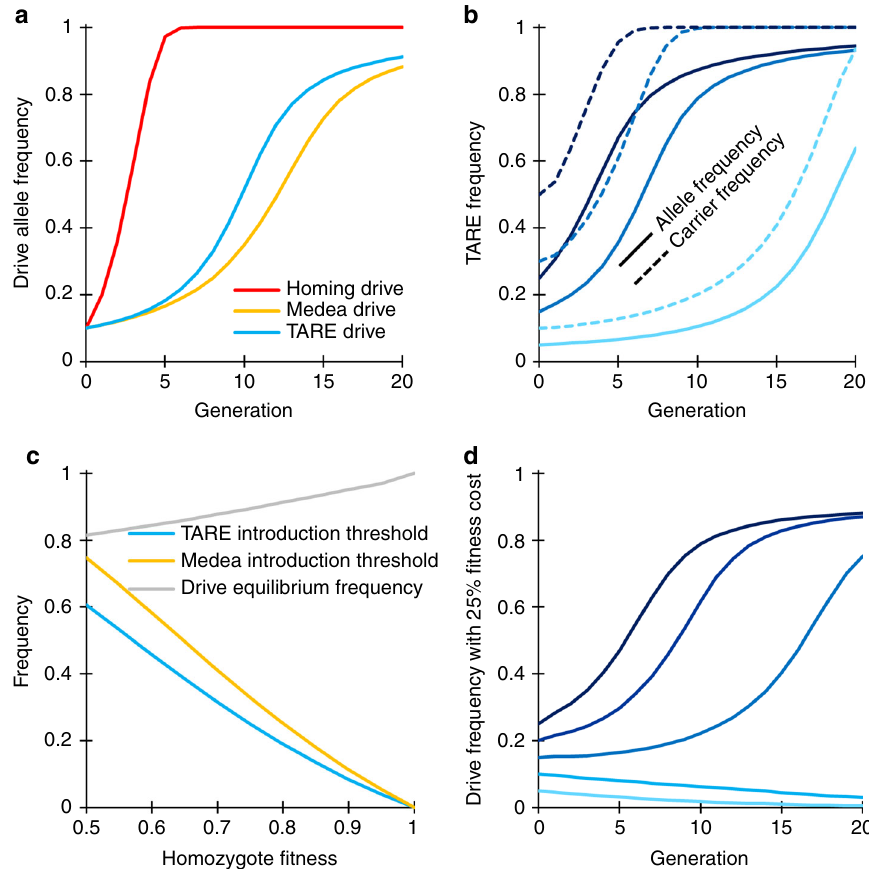
Fig. 2 TARE drive dynamics. Expected drive trajectories for ideal drives were simulated in a deterministic model of a single panmictic population with an initial release of drive/wild-type heterozygotes and assuming no fi tness costs. a An ideal TARE drive increases in frequency less rapidly than an ideal homing drive. It has similar dynamics to an ideal Medea drive, but with slightly increased speed to fi xation since both male and female drive individuals contribute to the disruption and subsequent removal of wild-type alleles. b A TARE drive is expected to show frequency-dependent dynamics, increasing in frequency more rapidly at moderate frequencies than at low frequencies. At high frequencies, however, the rate at which wild-type individuals are removed is slowed. Nevertheless, the drive should rapidly reach all individuals in a population (in the sense that most individuals should carry at least one copy of the drive) with a moderate initial release size. c Invasion threshold frequencies of drive heterozygotes as a function of the fi tness cost of the drive in homozygotes. These thresholds represent unstable equilibria above which the drive increases in frequency and below which the drive is removed. With fi tness costs, both TARE and Medea drives will not reach fi xation, but instead reach an equilibrium frequency as shown, which is the same for both types of drives. Note that all individuals at equilibrium still have at least one copy of the drive allele. d Drive allele frequency dynamics when assuming a drive homozygote fi tness equal to 75% that of wild-type individuals, which yields a threshold heterozygote release frequency of 25% (12.5% allele introduction